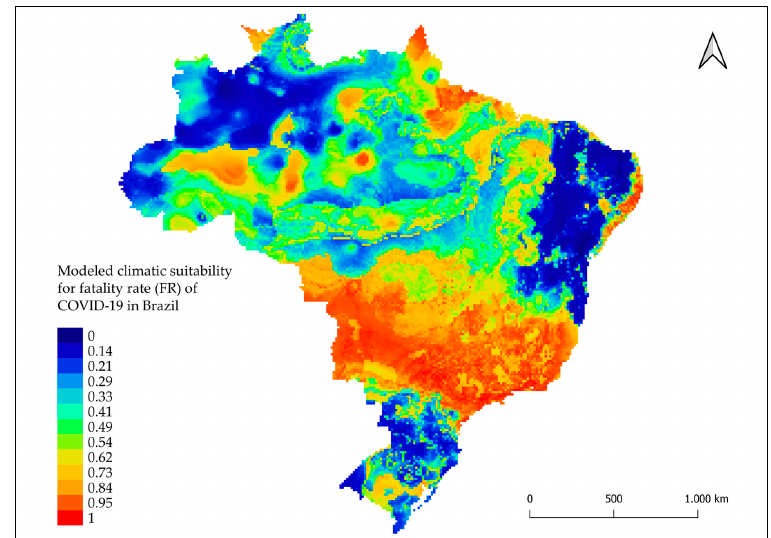
Figure 4. Modeled climatic suitability for mortality rate (MR) of COVID-19 in Brazil. Modeled cli- matic suitability (consensus model) for all seven algorithms under current climate conditions. Data used for modeling was provided by WorldClim [17]. For visualization, maps were built using QGIS version 3.16 (h tt ps://qgis.org/pt_BR/site/, accessed on January 10 2022).